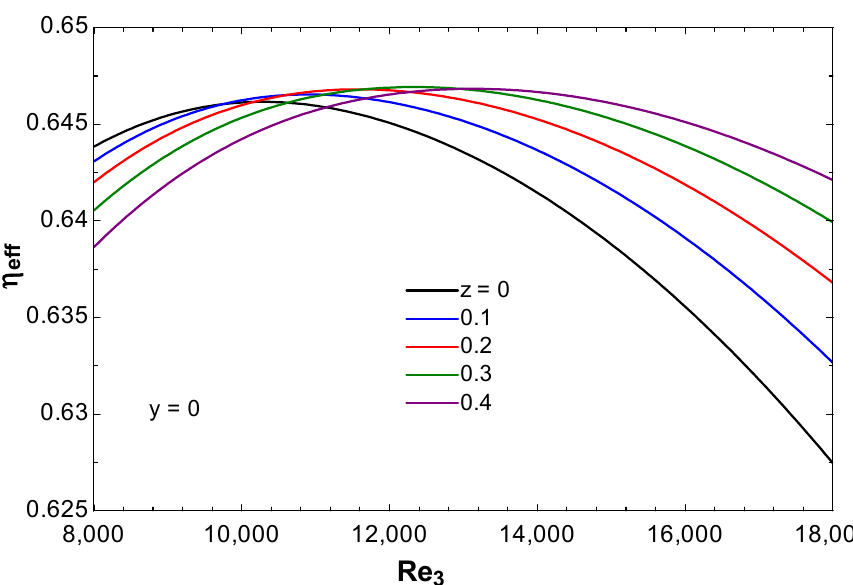
Energies 2021 , 14 , x FOR PEER REVIEW Figure 9. Effect of airflow ratio z and Reynolds number on thermohydraulic efficiency.